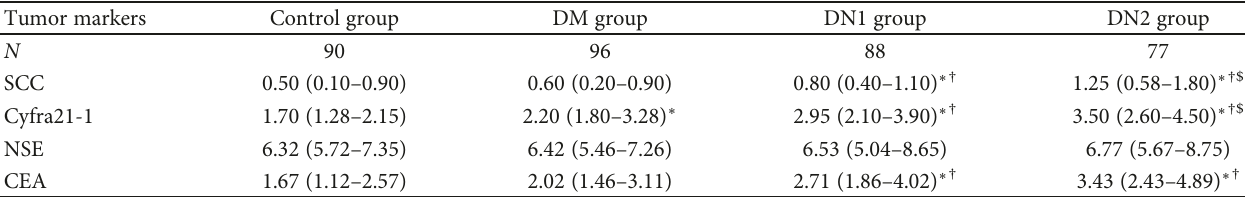
Table 2: Serum tumor marker levels in diabetic patients and